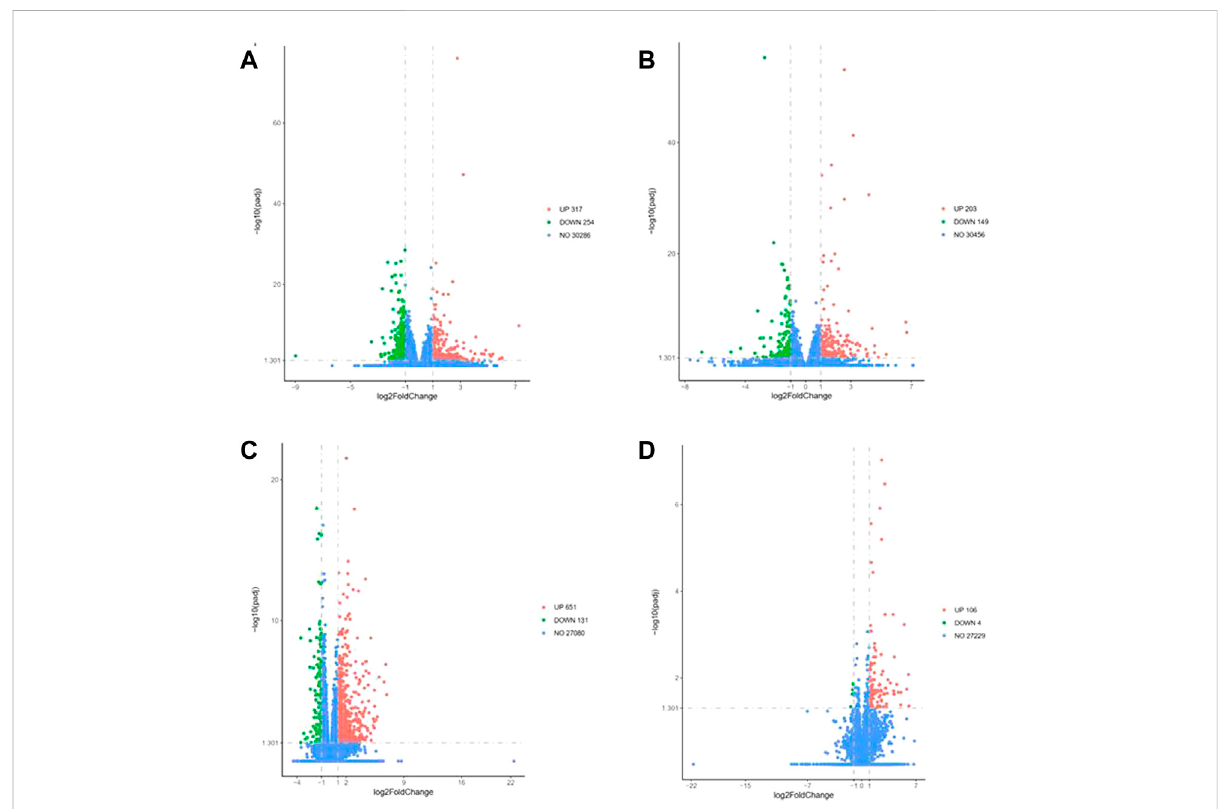
FIGURE 3 Volcano map of differentially expressed genes at 3 months in the (A) low-dose irradiation group, and (B) high-dose irradiation group, and at 6 months in the (C) low-dose irradiation group, and (D) high-dose irradiation group (|log2(Fold Change)| > 1 & Padj < 0.05). Thirty mice were randomizedinto3groups:controlgroup,low-doseirradiation(16 Gy)groupandhigh-doseirradiation(20 Gy)group.Lungtissueswereharvestedat 3 and 6 months after radiation to perform RNA